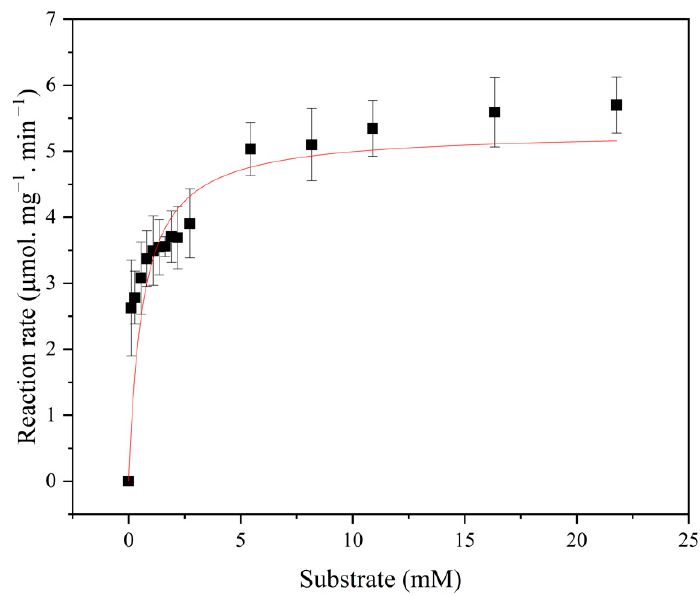
Table 1. Carbon and nitrogen sources in culture medium for standard and alternative culture media used to produce ALDC by B. subtilis ICA 56. The remaining media components were kept constant. Experiments were carried out in a rotary shaker at 37 °C, 150 rpm, for 14 h. Figure 8. Effect of substrate concentration on reaction rate. Ethyl-2-acetoxy-2-methylacetoacetate was used as substrate, with concentrations ranging from 0.1 to 25 mM. Enzyme activities were measured at 30 °C and pH 6. K m and V max were obtained by fitting the experimental data to the Michaelis–Menten equation. The error bars represent standard deviations from three replicates.